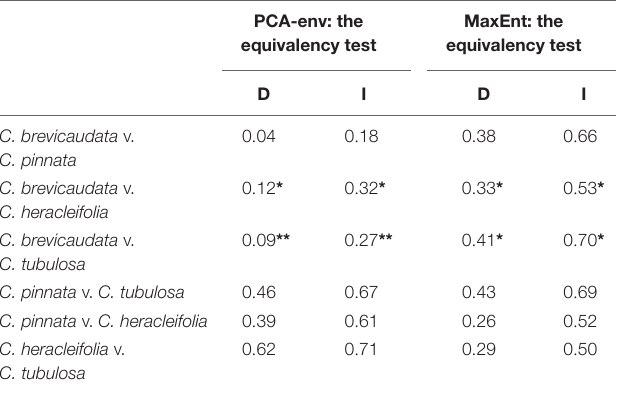
TABLE 4 | Niche overlap statistics between tested species pairs based on PCA-env and the equivalency test using Schoener’s D (Schoener, 1968) and Warren’s I (Warren et al., 2008). PCA-env: the equivalency